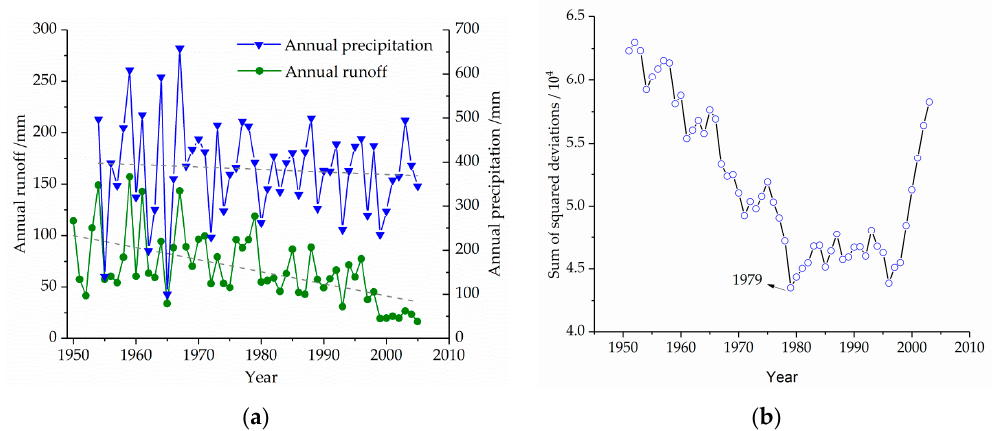
Figure 4. Variation characteristics of precipitation and runoff series. ( a ) The trends in annual runoff and annual precipitation, and ( b ) the result of ordered clustering, showing the variation point.